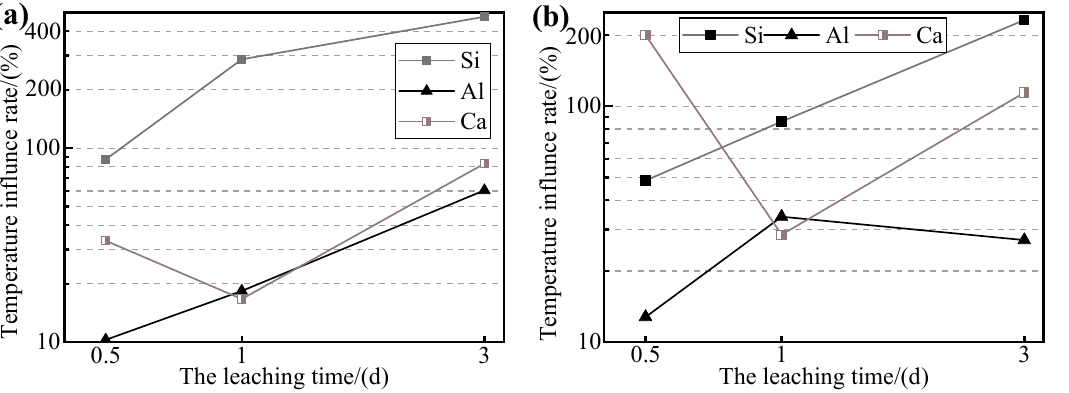
Figure 9. The influence of curing temperature on the ion leaching efficiency. ( a ) WPS was immersed in a solution of 5.0 M NaOH (S-5). ( b ) The mechanochemically and thermally activated WPS was immersed in a solution of 5.0 M NaOH (SC6G-5). The XRD of the residues after leaching for 28 days at 20 ◦ C and after leaching for